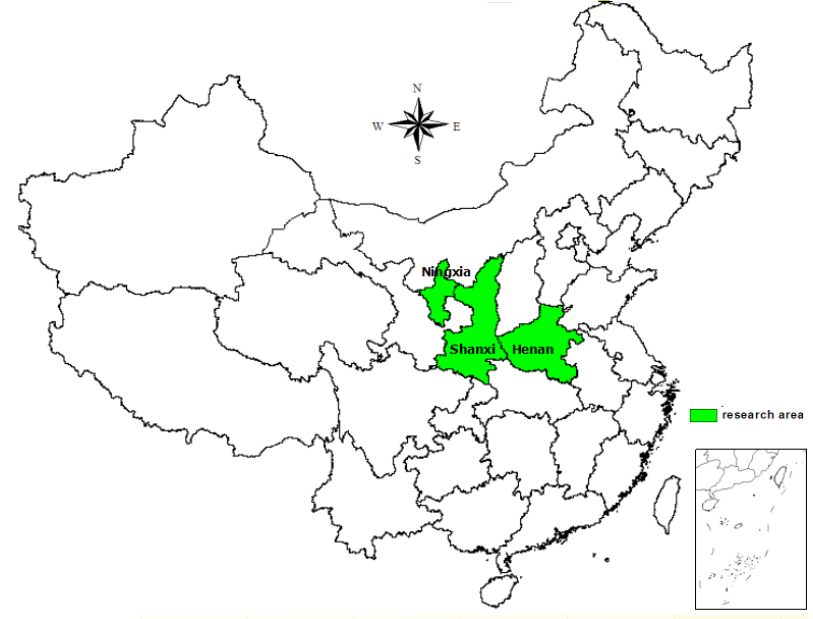
Figure 1. The main survey areas (Shanxi, Henan, Ningxia) in China.